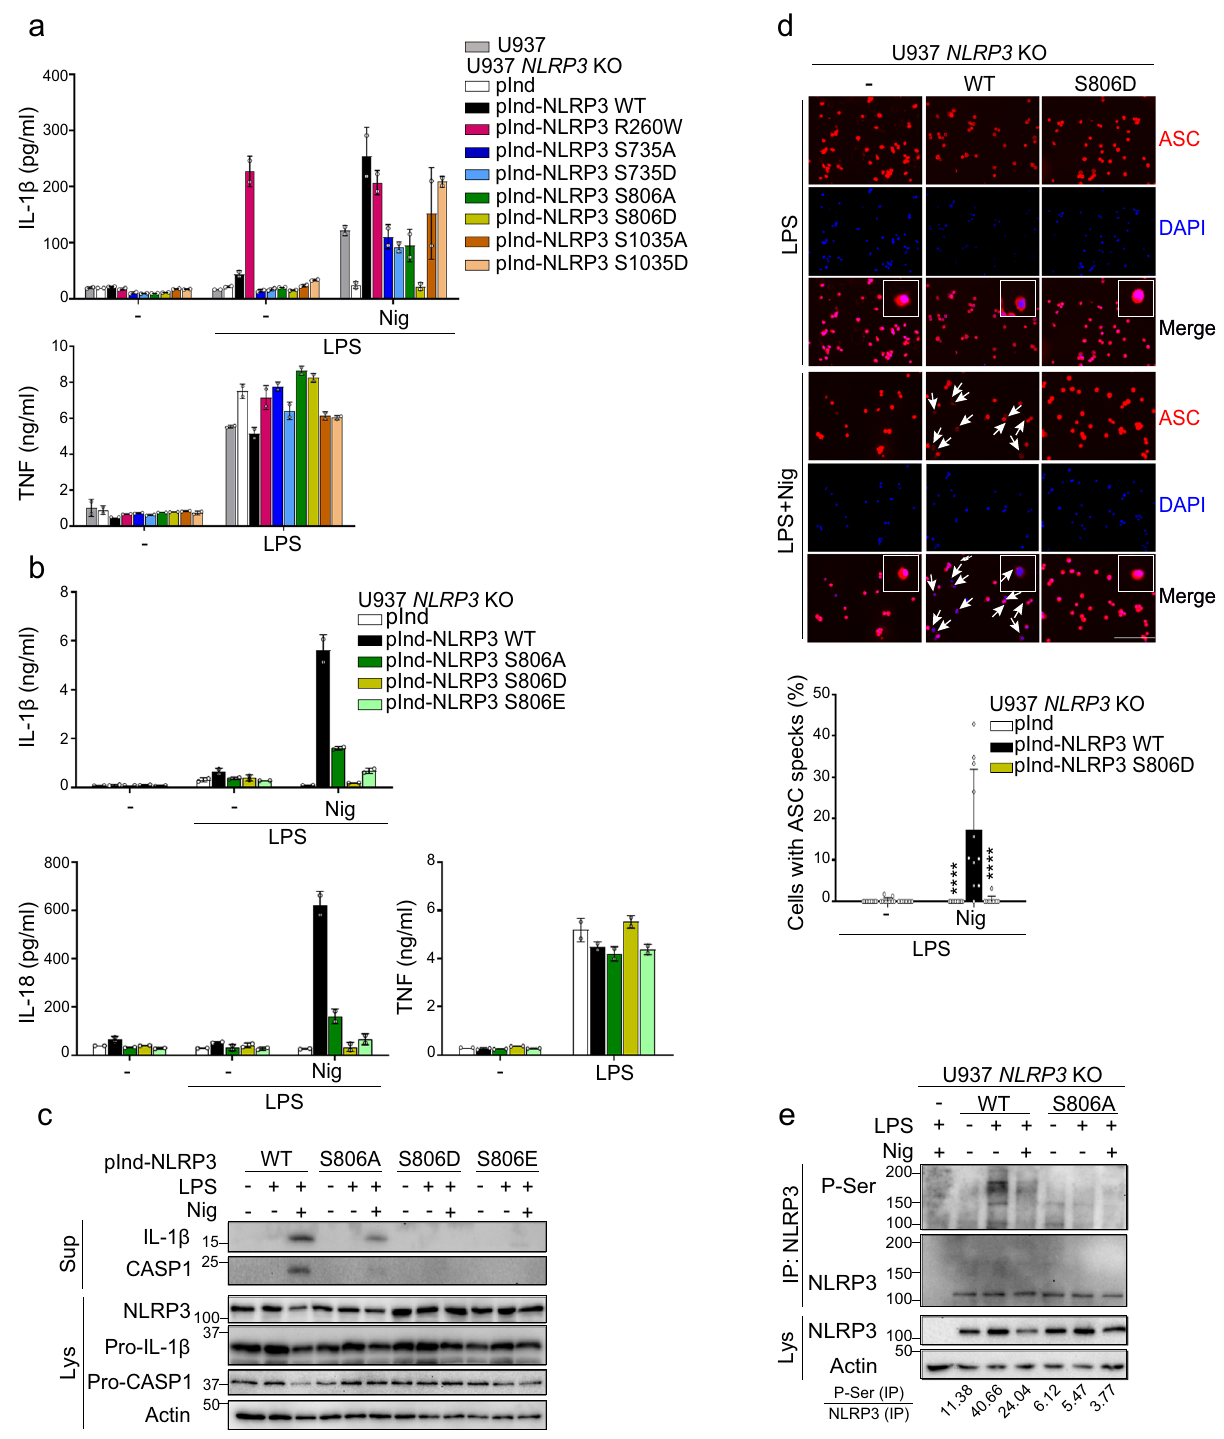
(Fig. 4e, f). In addition, NLRP3 S803D did not co- transfection both activating the NLRC4 in fl ammasome (Supple- immunoprecipitate with ASC in Nlrp3 S803D/S803D BMDMs trea- mentary Fig. 4g, h). In addition, LPS-primed Nlrp3 S803D/S803D BMDMs secreted IL-1 β and underwent pyroptosis in response to ted with LPS and nigericin (Fig. 4g). Consistently, LPS-primed poly(dA:dT) transfection which activates the AIM2 in fl ammasome Nlrp3 S803D/S803D BMDMs infected with Escherichia coli , or Pam3CSK4-primed Nlrp3 S803D/S803D BMDMs transfected with (Supplementary Fig. 4i). LPS, did not secrete IL-1 β which relies on the NLRP3 in fl amma- some, but underwent pyroptosis which depends in both settings on NLRP3 S803D does not recruit NEK7 . We next investigated the the caspase-11 non-canonical in fl ammasome (Supplementary mechanism of in fl ammasome blockade by NLRP3 S803 phospho- Fig. 4e, f). As controls, LPS-primed Nlrp3 S803D/S803D BMDMs mimetic substitutions. NEK7 has been shown to be a key com- secreted IL-1 β in response to S. Typhimurium infection or fl agellin ponent of the NLRP3 in fl ammasome that interacts and bridges NATURE COMMUNICATIONS| (2021) 12:5862